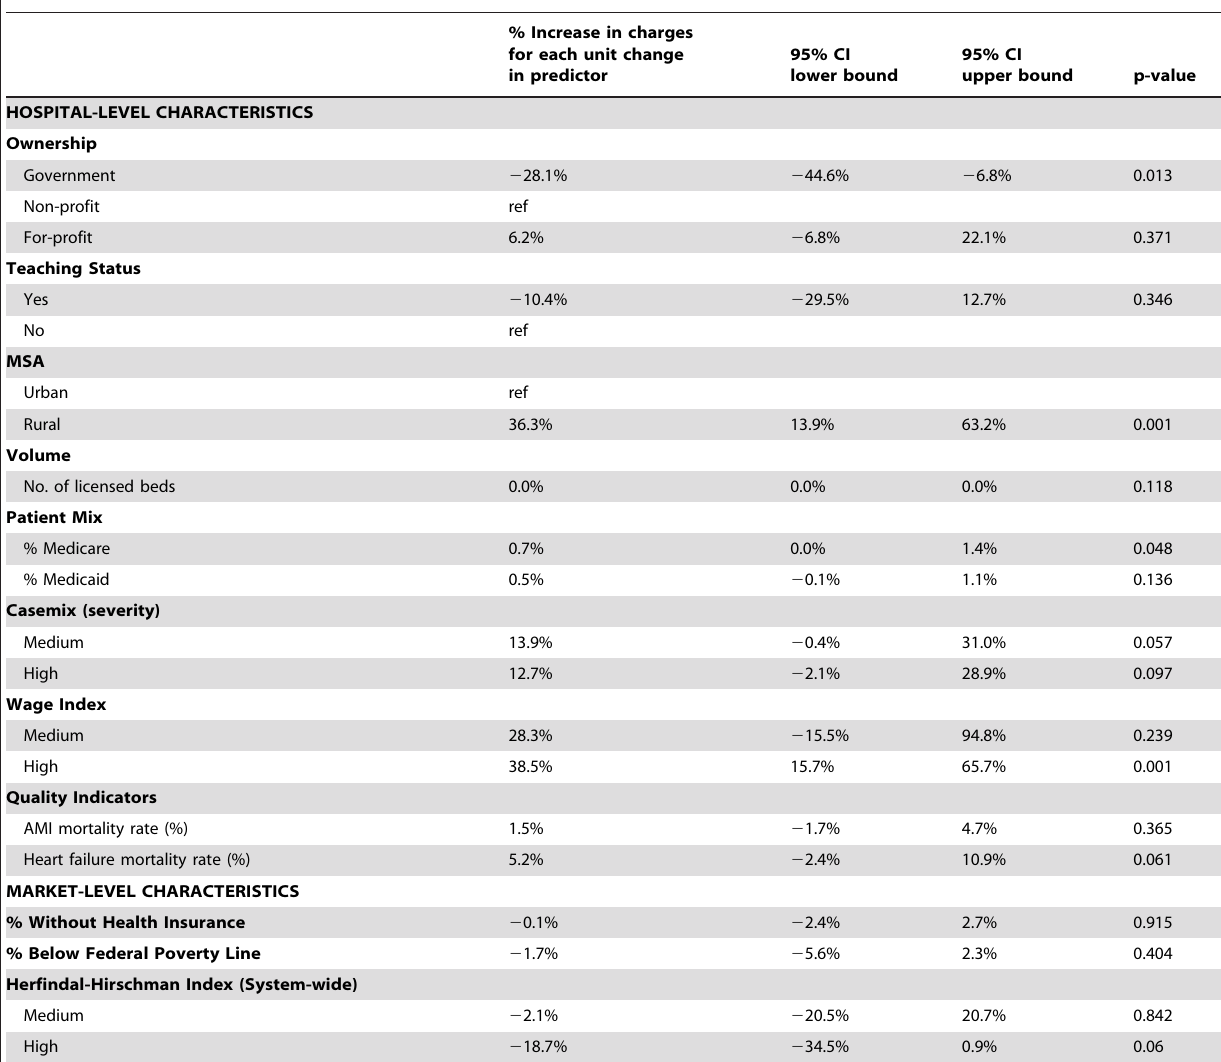
Table 3. The impact of hospital and market characteristics on adjusted charges.